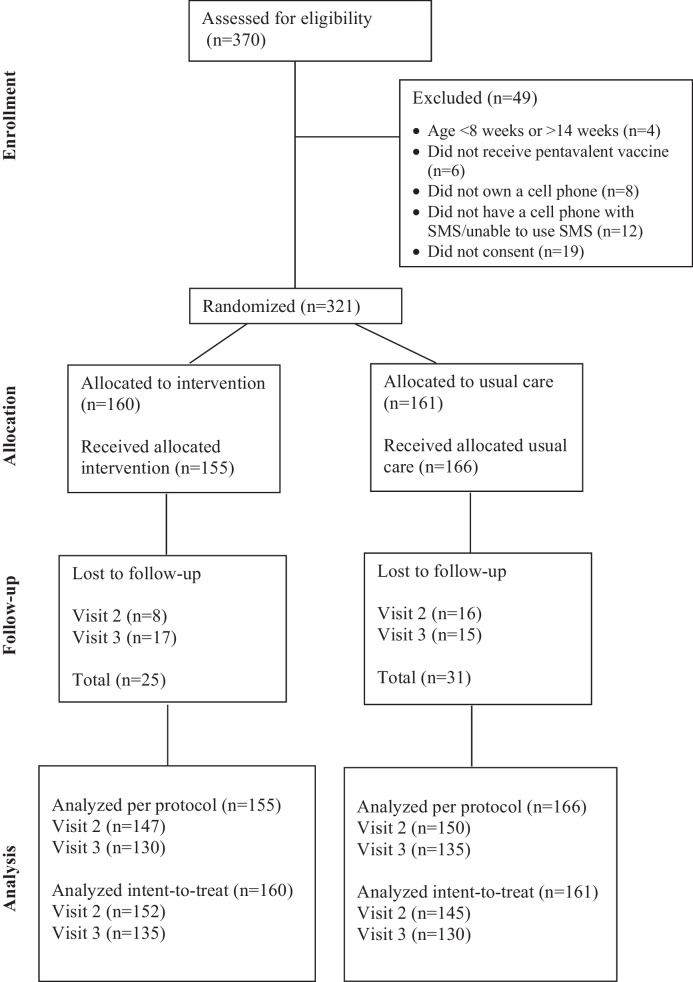
CONSORT diagram.